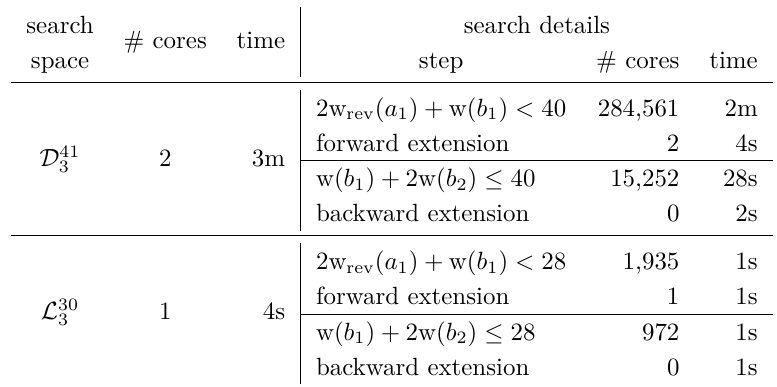
Table 3: Details on the generation of canonical 3-round differential and linear trail cores below target weight 41 and 30,